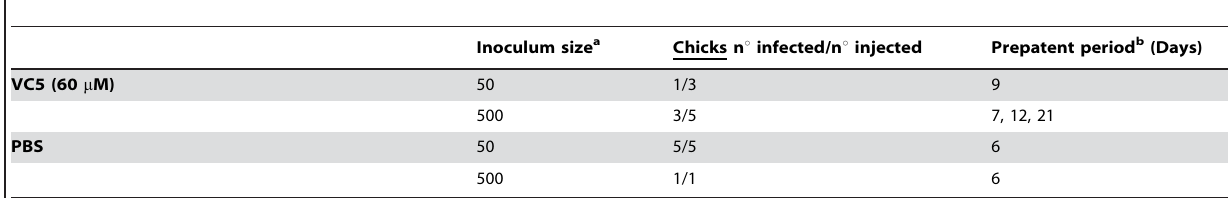
Table 1. Infectivity for chicks of P. gallinaceum spzs from salivary glands after incubation with 60 m M of